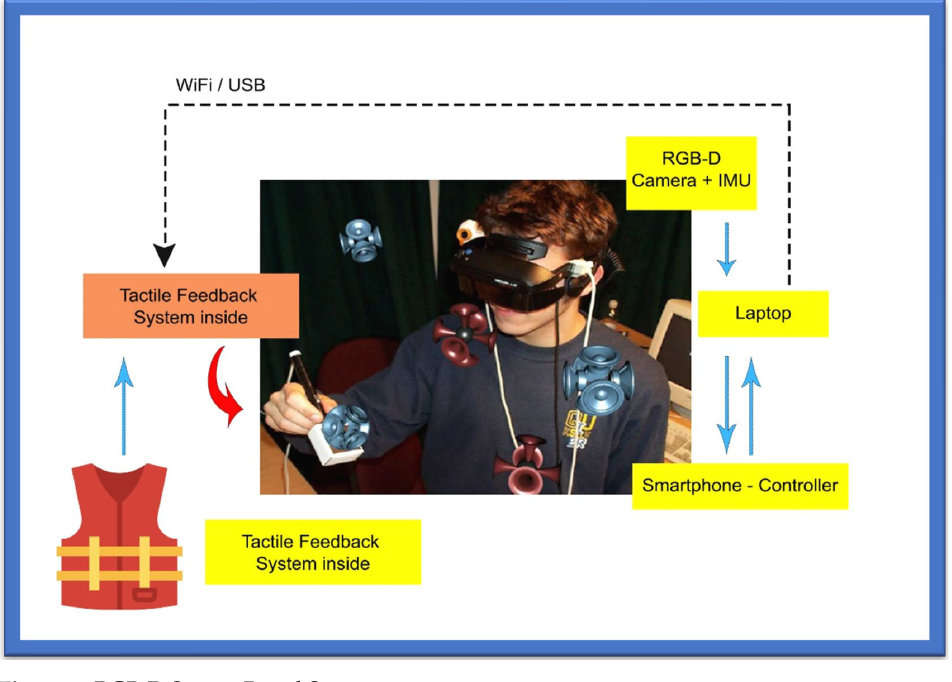
Figure 7. RGB-D Sensor-Based System. Table 9. Properties of RGB-D Sensor-Based Navigation Tools.